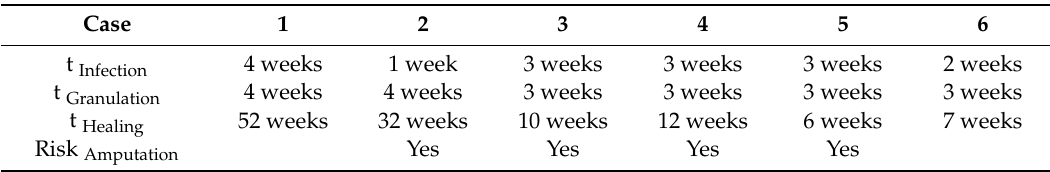
Table 1. Wound healing trajectory per case, including time to full healing, time to reduce inflammation, and infection control.